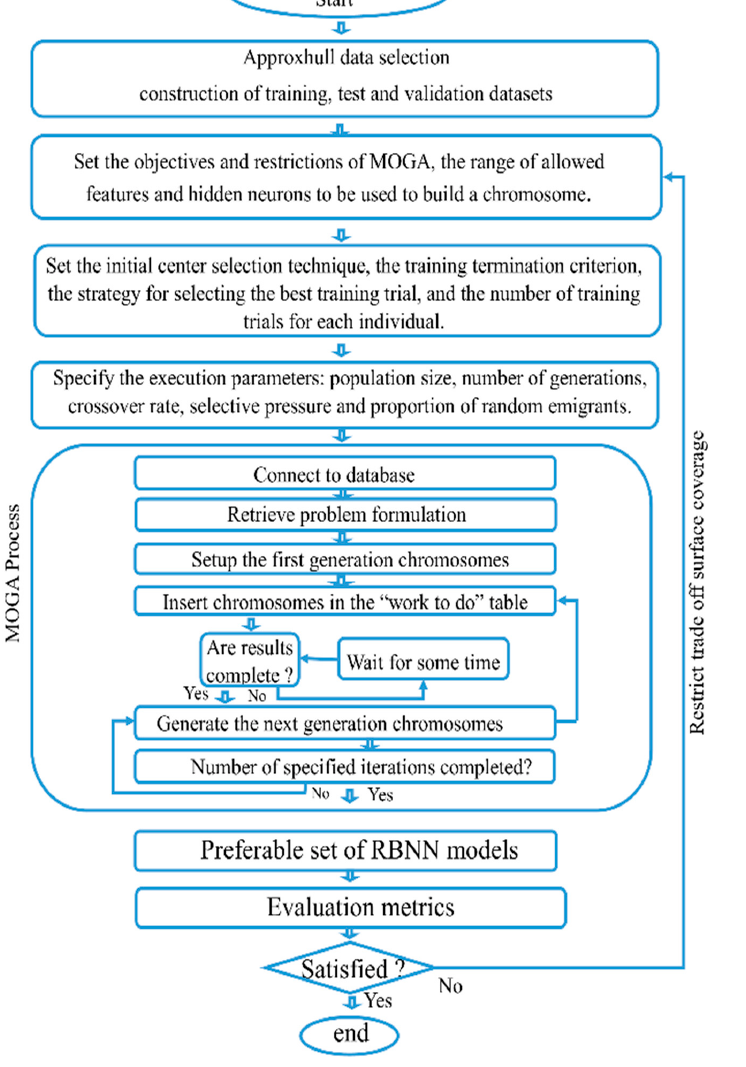
Figure 3. Overview of the design